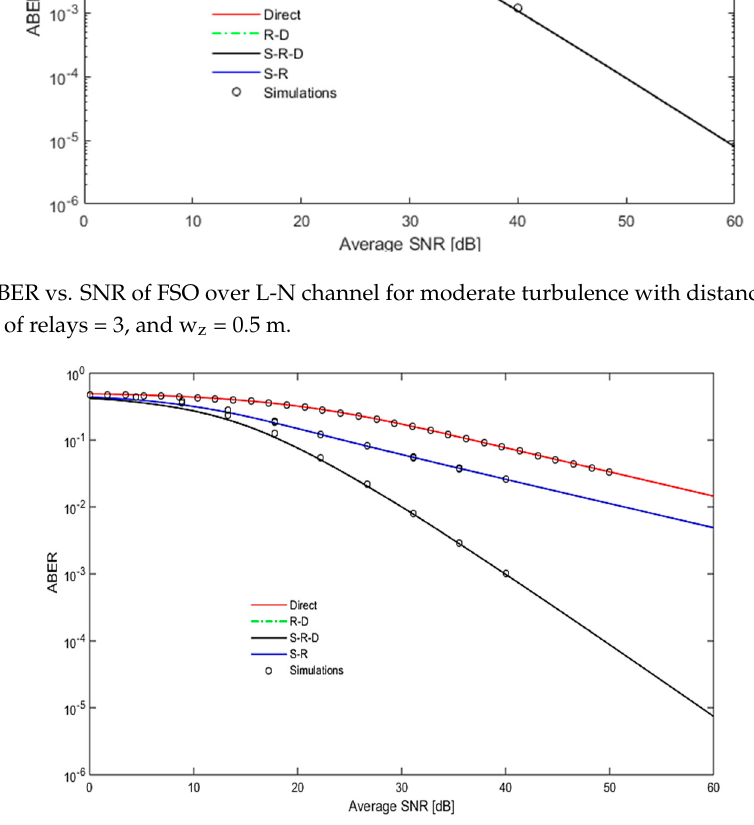
Figure 10. ABER vs. SNR of FSO over L ‐ N channel for moderate turbulence with distance 600–400 m, the number of relays = 3, and w z = 0.5 m.